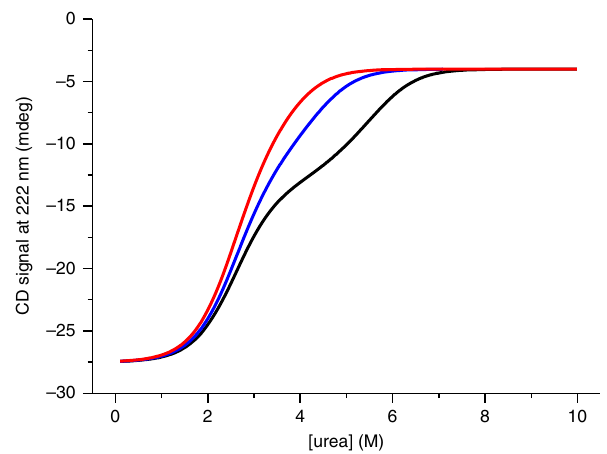
Fig. 6 Theoretical denaturation curves of the CTD of varying free energy of dimerization. Simulated denaturation curves of 10 µ M CTD using the model for a three-state equilibrium involving a dimeric intermediate. The curves contain the thermodynamic parameters derived from the fi t to experimental data of wild-type CTD (free energy of dimerization: Δ G I2-D = 14 kcal mol − 1 , black line). Simulated denaturation curves using the same model